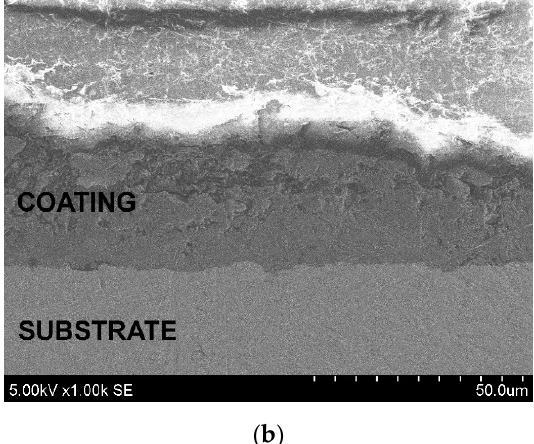
Torch Input Power, kW Al,